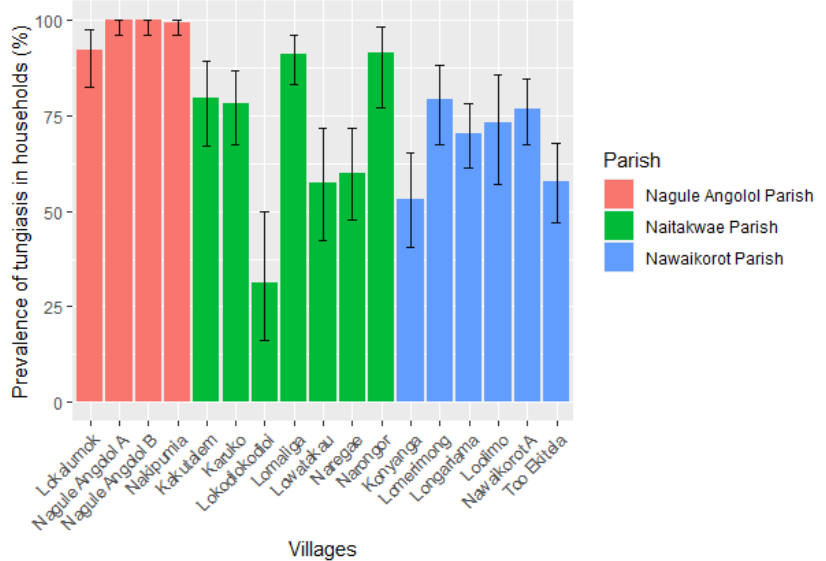
Figure 3. Prevalence of human tungiasis among households in the 17 study villages. The error bars show a 95% confidence interval ( n = 1278). Table 1. Prevalence of human tungiasis in the 17 villages of the three parishes.